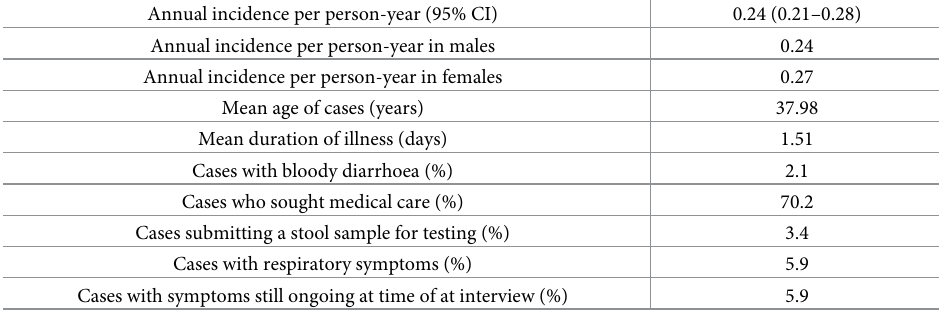
Table 6. Descriptive statistics of acute gastrointestinal illness following the proposed standard case definition of gastrointestinal illness in Zhejiang Province, China, July 2018–June